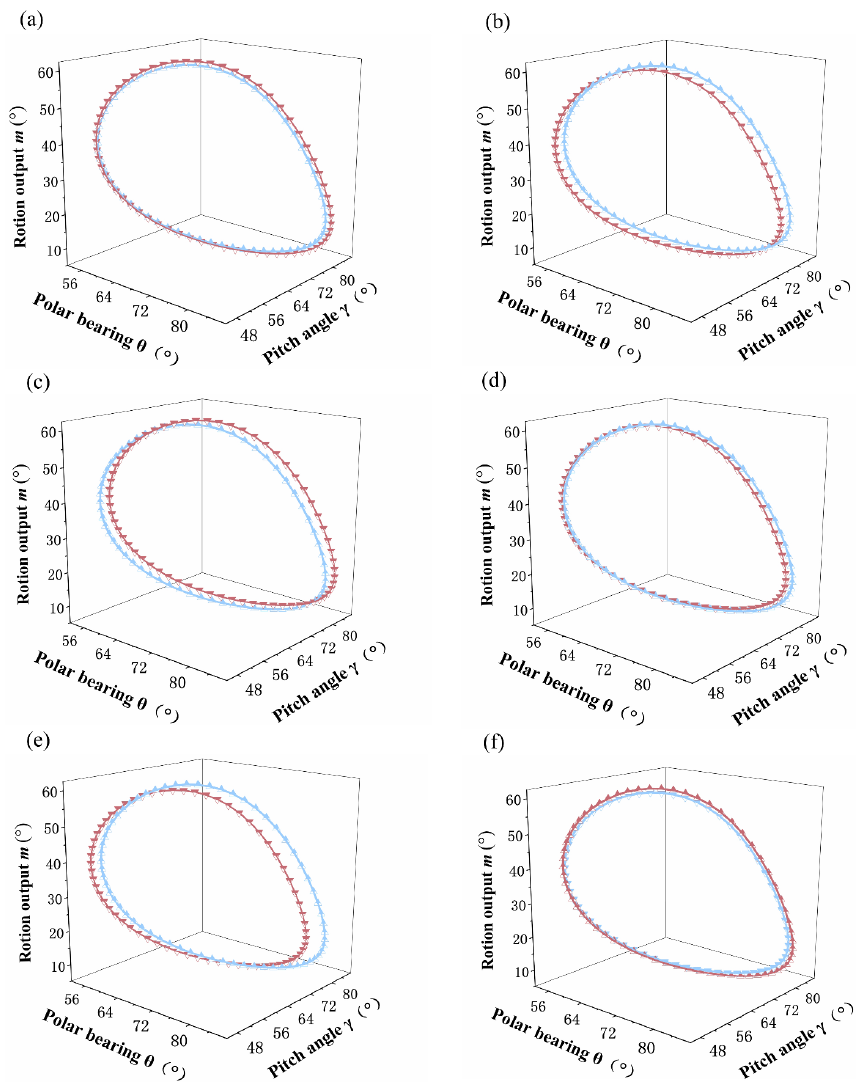
Figure 8. The MOBDT with different